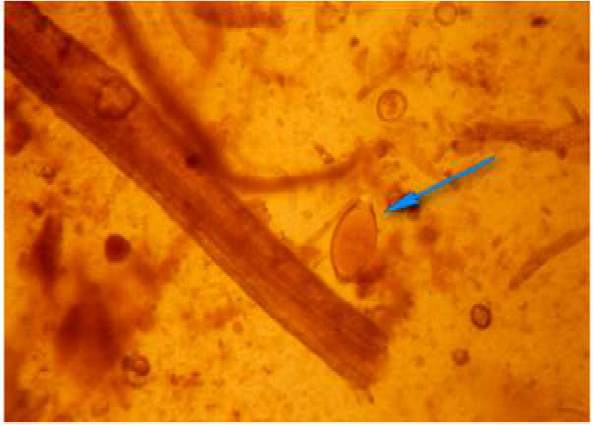
Figure-1. Photomicrograph of Trichurid egg isolated from faecal sample of camel in Sokoto metropolis (X10)